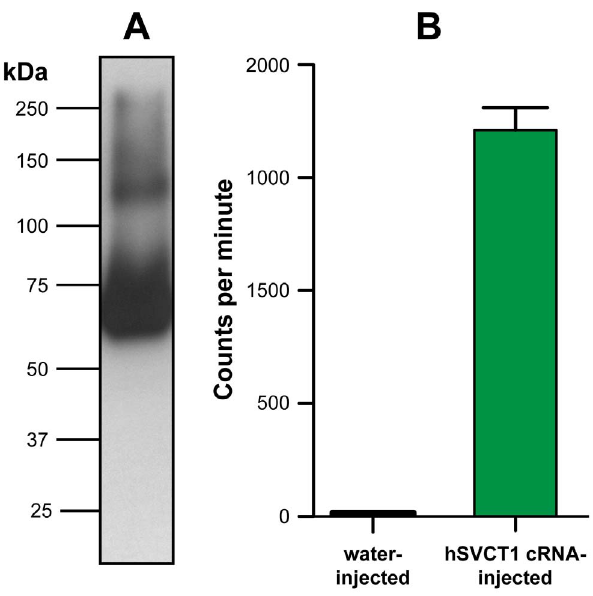
Figure 1. Expression and function of hSVCT1 in Xenopus oocytes. (A) Western blot analysis of isolated membranes from three oocytes expressing hSVCT1. Western blotting was performed using a 6% SDS/polyacrylamide gel and an anti-HA antibody. The prominent band below the 75 kDa marker corresponds to recombinant hSVCT1 (calculated molecular mass based on the amino acid sequence: , 71 kDa). A second, less prominent band between the 100 kDa and 150 kDa markers was assigned to dimeric hSVCT1. (B) Oocytes injected with hSVCT1 cRNA mediate uptake of [ 14 C]ascorbate in contrast to control oocytes injected with water. Mean 6 SEM from 20 oocytes are indicated (two independent experiments).